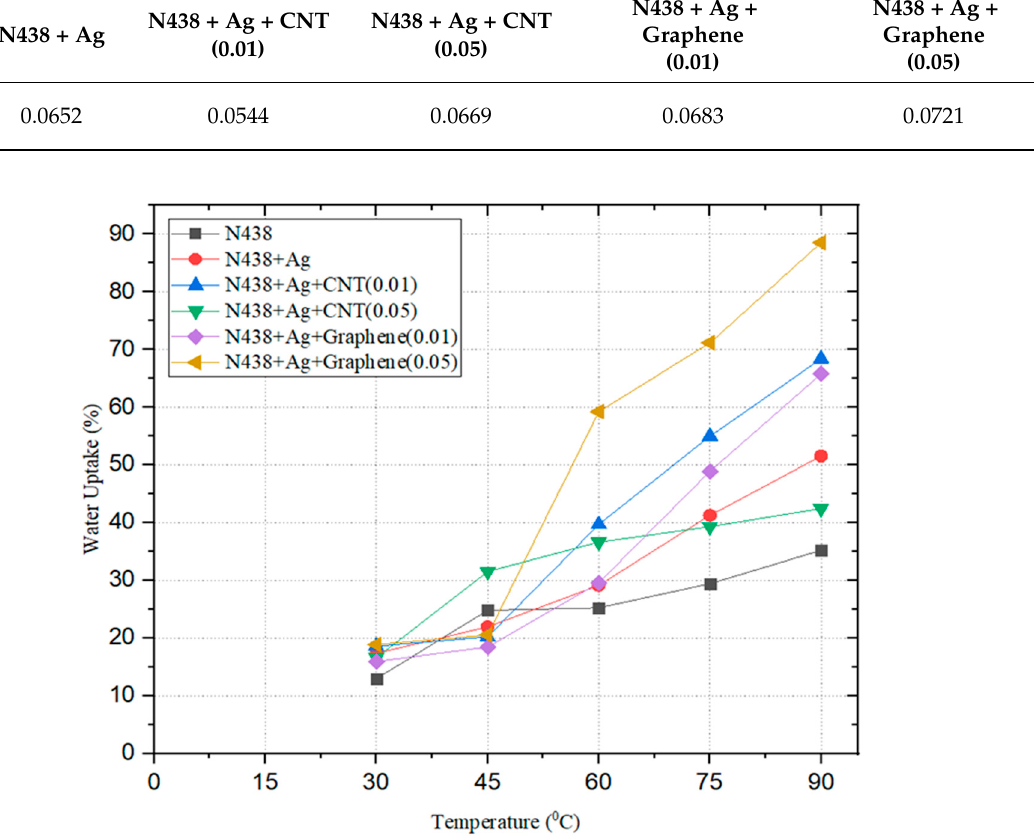
Table 3. Weight of the Samples before immersing in hot water.